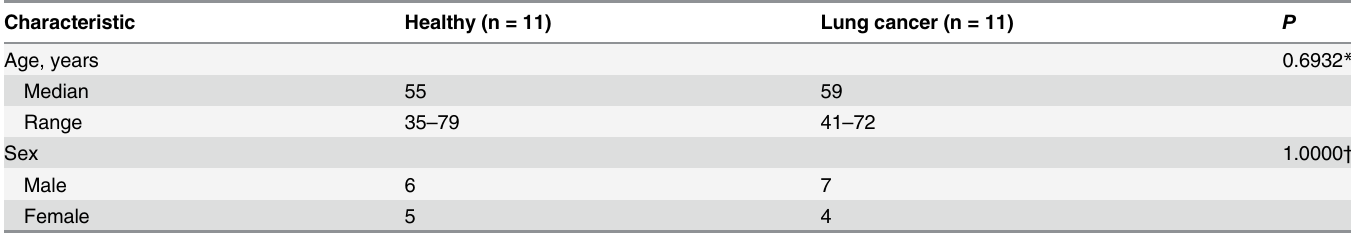
Table 1. Participants ’